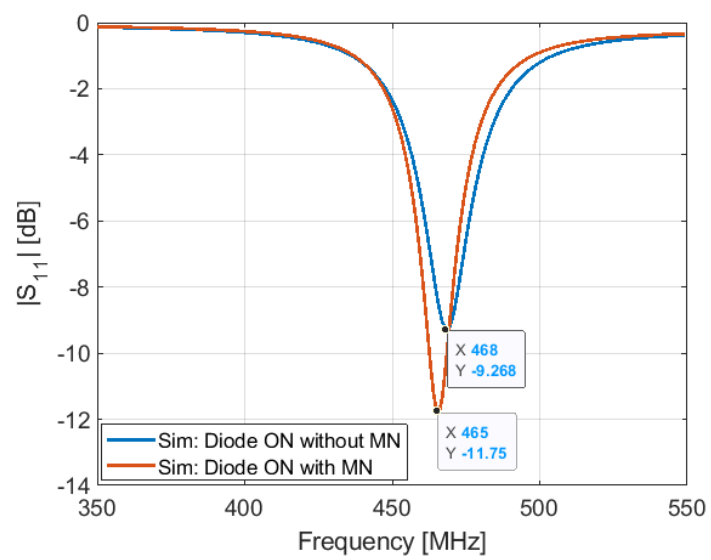
Figure 8. Simulated S11 of the antenna in ON configuration with and without matching network.